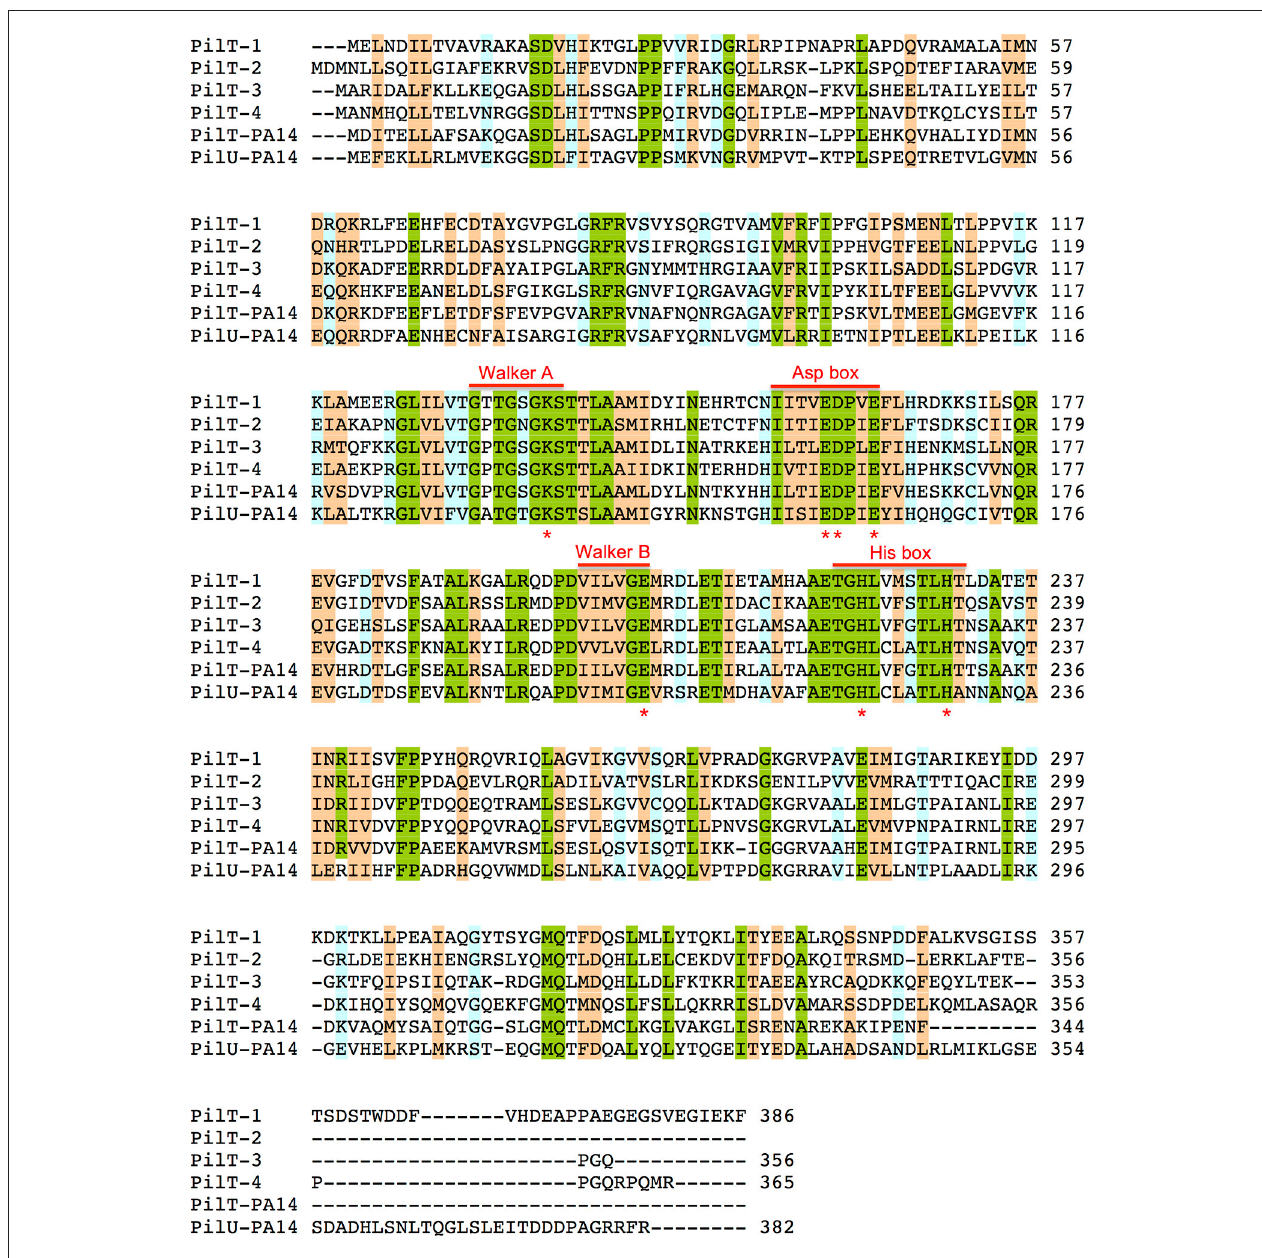
FIGURE 1 | Amino acid sequence alignments of PilT proteins from G. sulfurreducens and P. aeruginosa PA14. Multiple sequence alignment analysis was carried out using Clustal O (1.2.2) program at the UniProt database (http://www.uniprot.org). Shaded areas show positions in the alignment with a single, fully conserved residue (green) or with conservation between groups of strongly (orange) or weakly (blue) similar properties (Gonnet PAM 250 matrix scoring > 0.5 or ≤ 0.5, respectively). The conserved Walker A and Walker B motifs and Asp and His boxes of secretion ATPases are indicated. Red stars under the sequence alignment mark highly conserved lysine (Walker A), glutamate (Walker B), aspartate and/or glutamate (Asp box) and histidine (His box) residues that are essential for PilT activity.